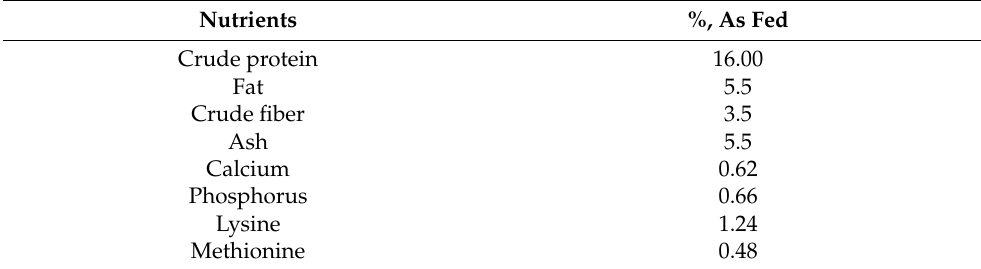
Table 1. Nutrient content of the commercial diet 1